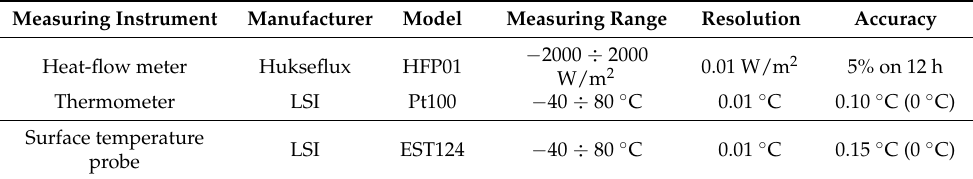
Figure 3. Schematic representation of the experimental setup in the reference test room ( a ) and in the insulated one ( b ). Table 2. Technical Specifications of the Measuring Instruments.